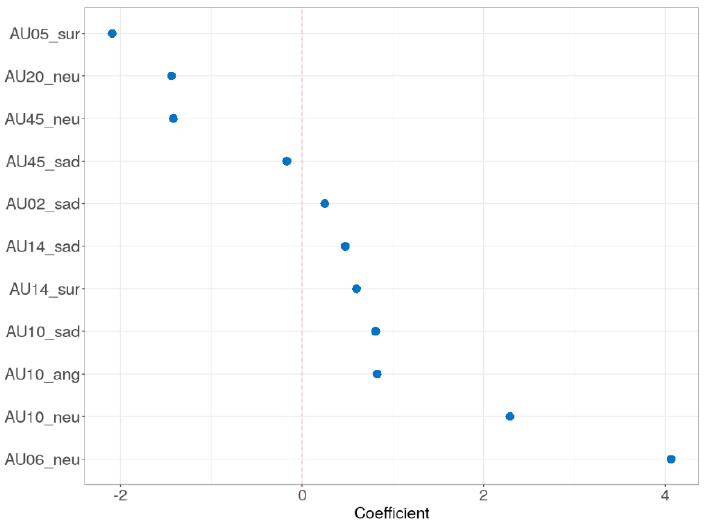
Figure 5. The adaptive LASSO results. AU, action unit; ang, angry; neu, neutral; sur, surprise.